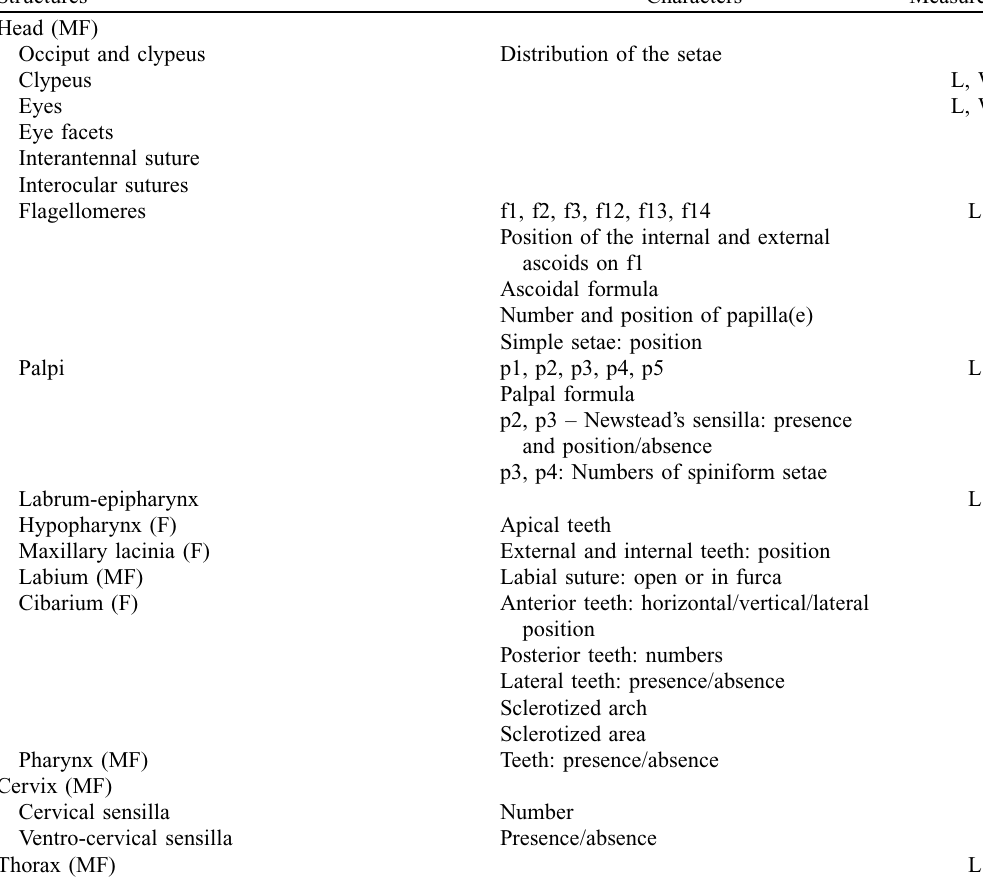
Table 1. Suggestion of the characters and the respective terminology used for the description of a new phlebotomine fly species. L = length; W = width; M = male; F = female; X = include the